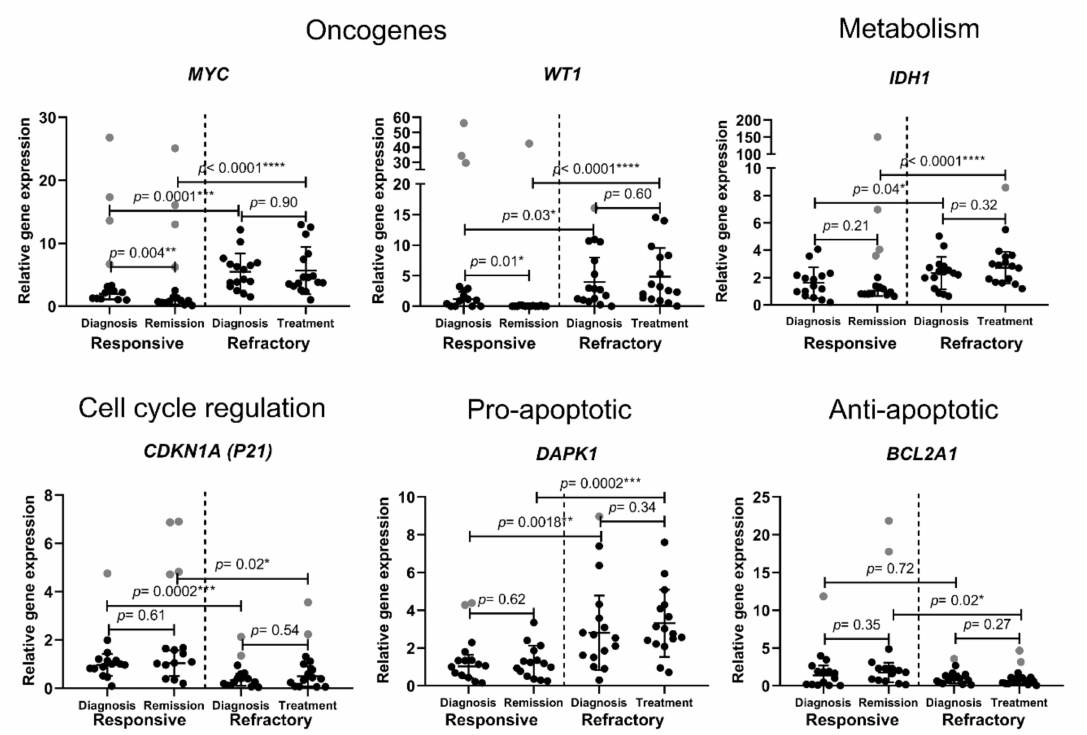
Figure 1. Cell-fate-important gene expression analysis in treatment-responsive and -refractory AML patients. Cell samples were collected at diagnosis stage and after treatment. Relative gene expression analysis was performed using the RT-qPCR ∆∆ Ct method; GAPDH was used as a “housekeeping” gene. Mean ± standard deviation is presented; grey data points indicate outliers. Mann–Whitney U test was used to determine the significance of difference between the groups of different patients’ samples, and significance was set at p ≤ 0.05 (*). Outliers were determined by ROUT (Q =